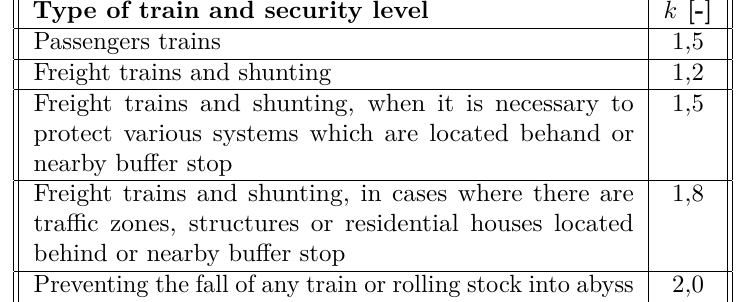
Table 3. Safety coefficient [3]